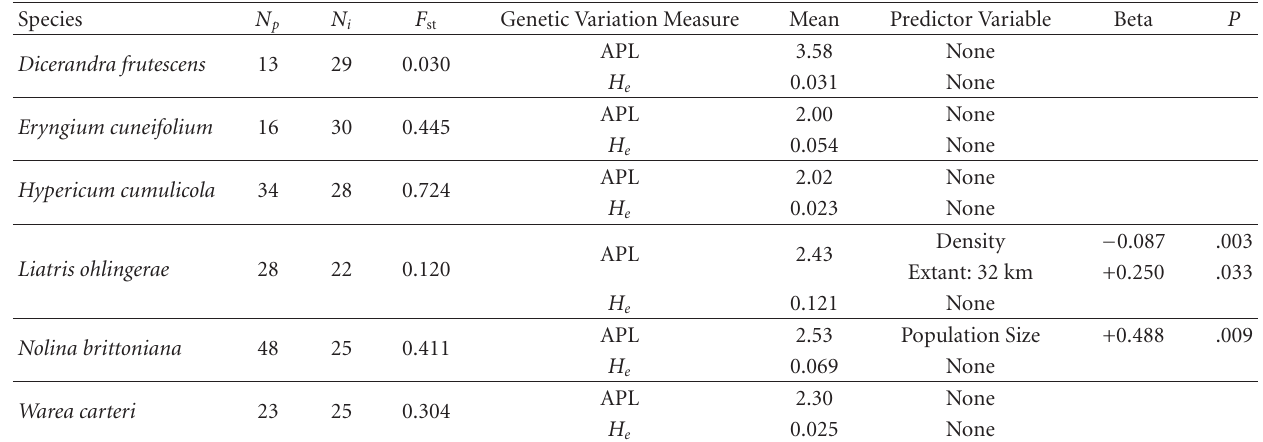
Table 2: Variables significant ( P < . 05) in predicting two measures of genetic variation, Alleles per Polymorphic Locus (APL) and Expected Heterozygosity ( H e ), in multiple regressions. N p refers to number of populations, N i refers to mean number of individuals sampled and scored per population. Variables were variously transformed before correlation analysis (see text). Beta is the standardized regression coe ffi cient, P refers to significance in model with all significant variables